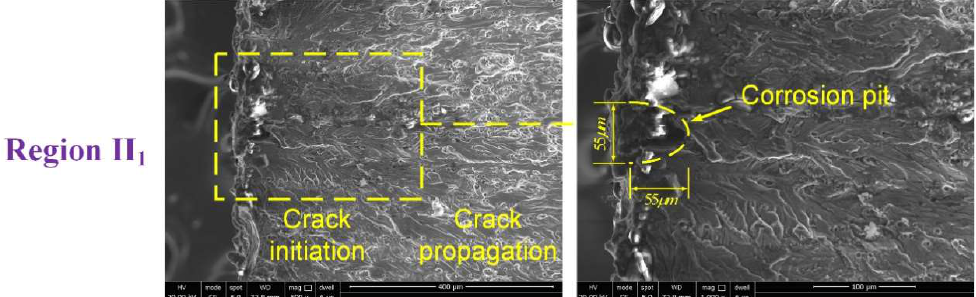
Figure 11. Fracture morphology of specimen with a corrosion time of 48 h.